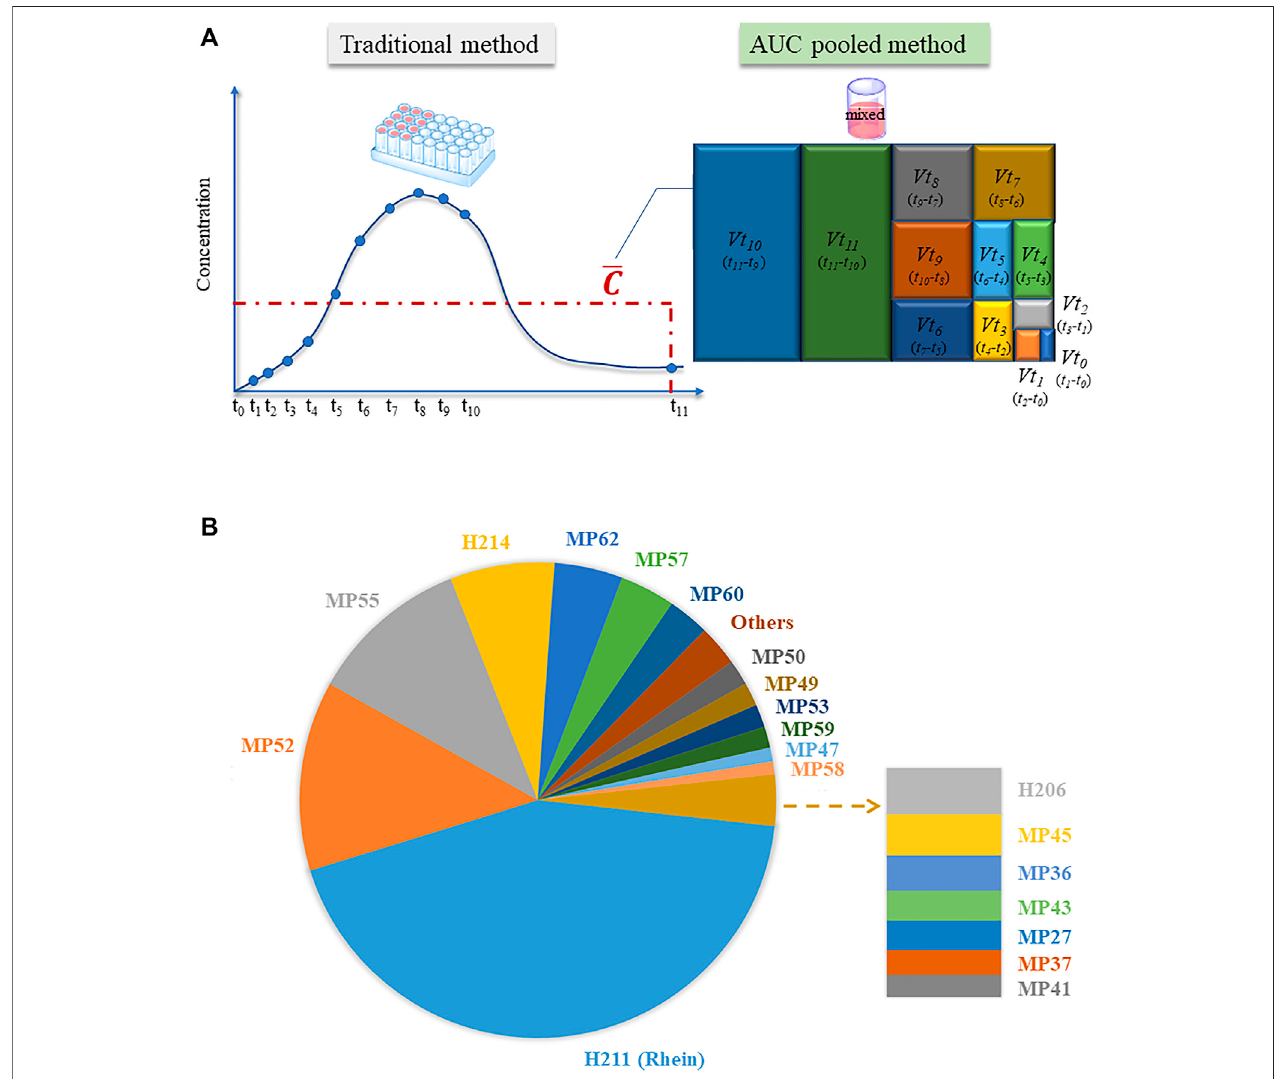
FIGURE3| Researchontheareaunderthetime-concentrationcurve(AUC)ofrelevantcomponents invivo . (A) Operationaldifferencesbetweenthetraditionaland AUC pooled methods; (B) Top 20 rhubarb-related components in vivo .